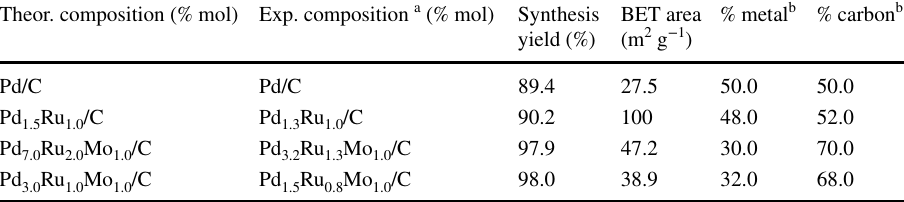
a Results obtained by EDX, b Estimated by